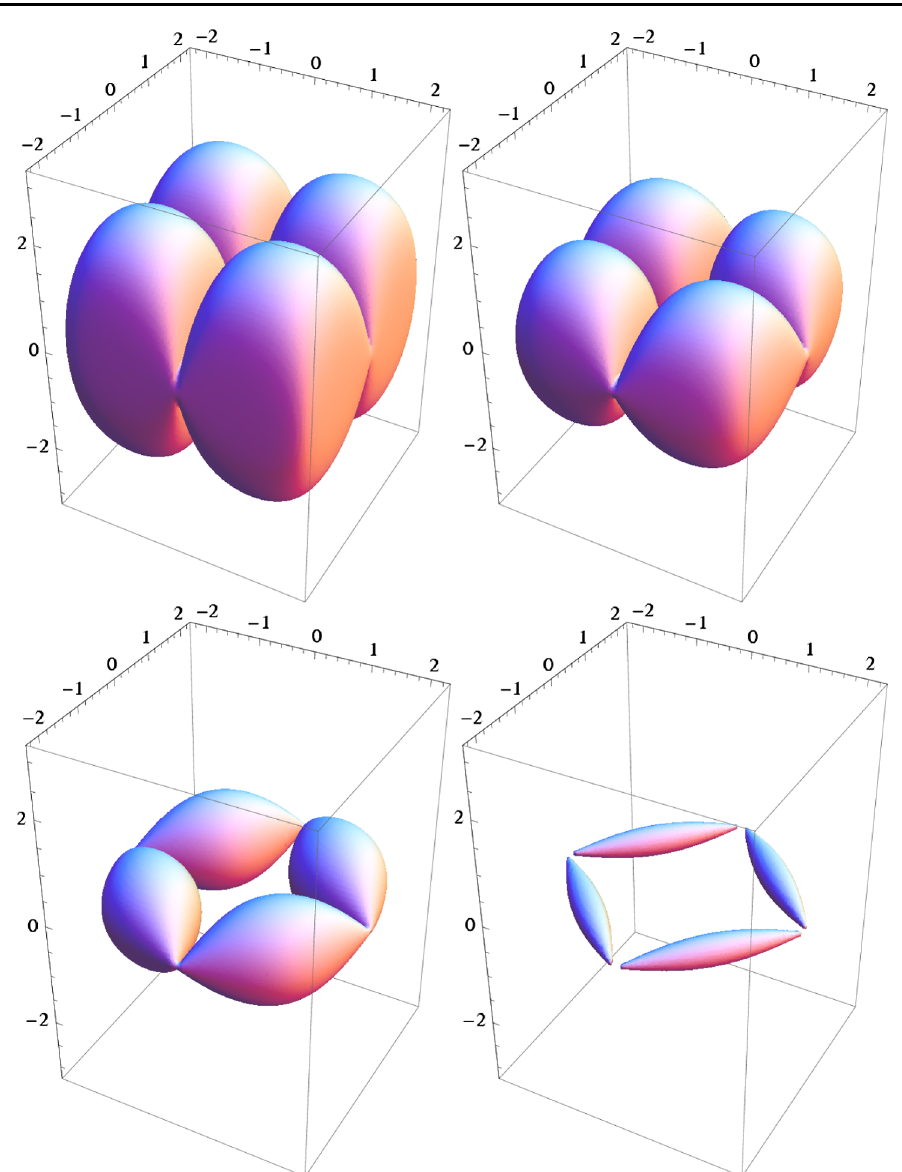
FIG. 4. The colored surfaces are 4 sets of equipotential surfaces of the potential (8). The quadrupole axis is vertical. In each case, the sides of the ‘‘box’’ containing the axes are also the 4 ground planes. All 4 give identical fields and the same sech 2 on-axis strength function if they are given the following potentials (left to right, top and then bottom), (cid:6) V have opposite